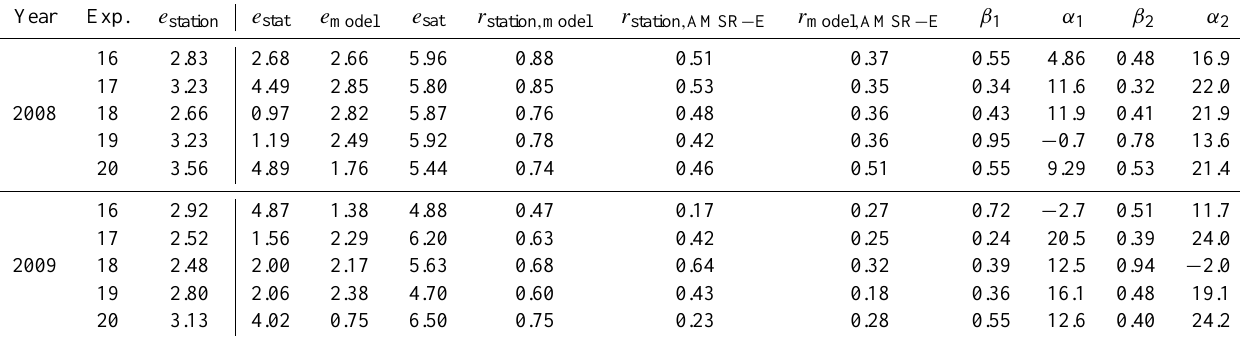
Table 3. Summary of soil moisture errors as estimated using triple collocation method for different stations: reference station error ( e station ), estimated errors for station, model and satellite ( e stat , e model , e sat ), correlation ( r ), gains β and offsets α of the relationships given by (6). Upscaling errors for the station used as variable x is shown for comparison ( e station ). Errors are given as [m 3 /m 3 ] ×